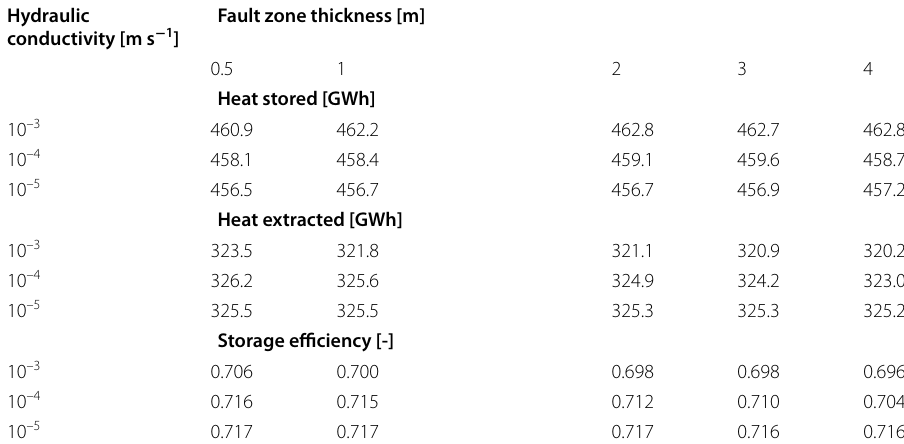
Table 3 Simulation results of all models Hydraulic conductivity [m s − 1 ]